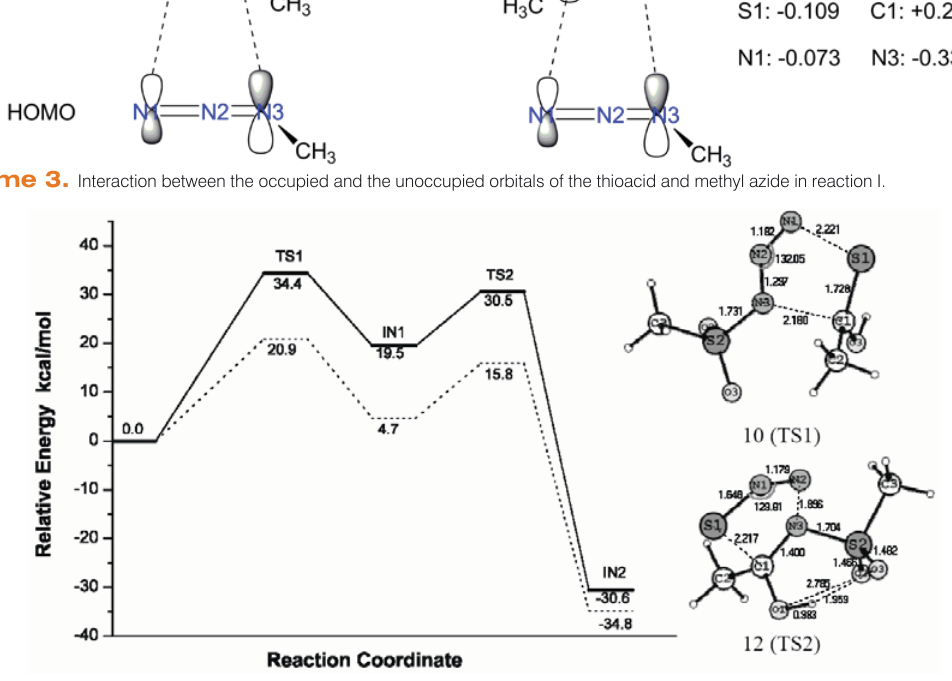
Figure 2. The potential energy profile for reaction II computed with B3LYP/6-31G(d)//B3LYP/6-311++G(d,p) method. Solid and dashed lines represent free energies ( ∆ G ) and ZPE corrected energies ( ∆ E ) relative to the reactants, 298 0